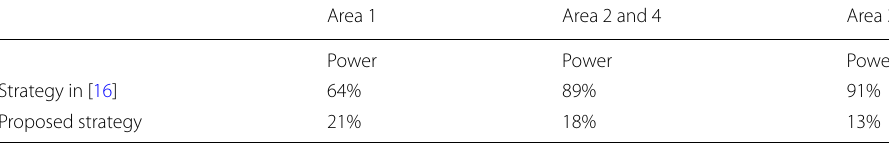
Table 11 Average power consumption for the transmission of Lena image